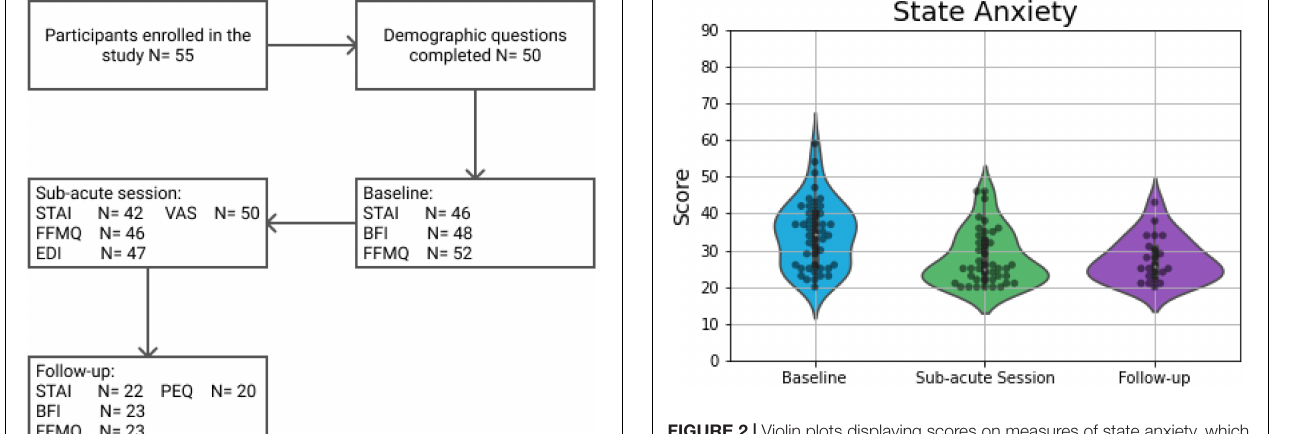
FIGURE 2 | Violin plots displaying scores on measures of state anxiety, which demonstrated significant differences between baseline and the other two time points. The plot consists of median (SE) ratings of state anxiety before, 1-day after and 7-days after psilocybin truffles. The thick line indicates the interquartile range, whereas the white dot indicates the median. Each gray dot indicates a data point, whereas the density is scaled to the relative count across all bins. Wider sections of the violin plot represent a higher probability of observations of a given value.